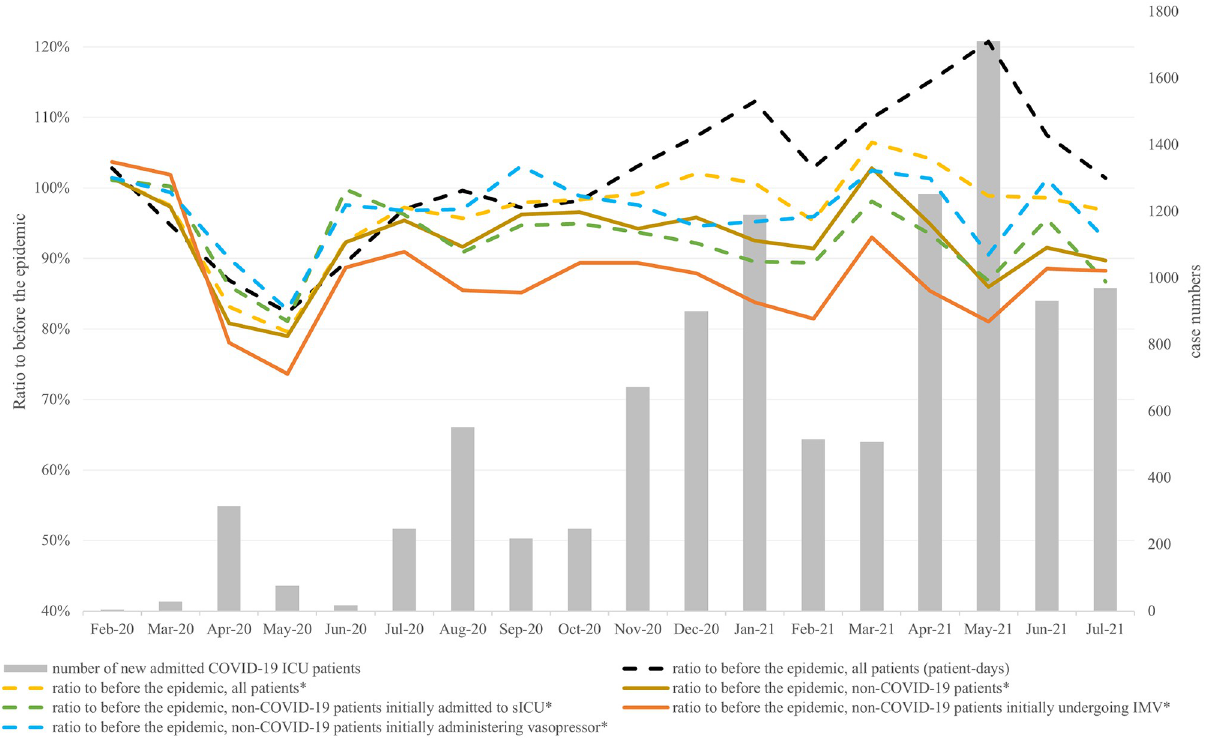
Fig 1. The trends in the ratios of case volumes of admissions to ICUs in each month to the same month before the epidemic. ICU, intensive care unit; COVID-19, Coronavirus disease 2019; sIUC, specialized-care ICU; IMV, invasive mechanical ventilation. � Indicates new admissions to ICU.